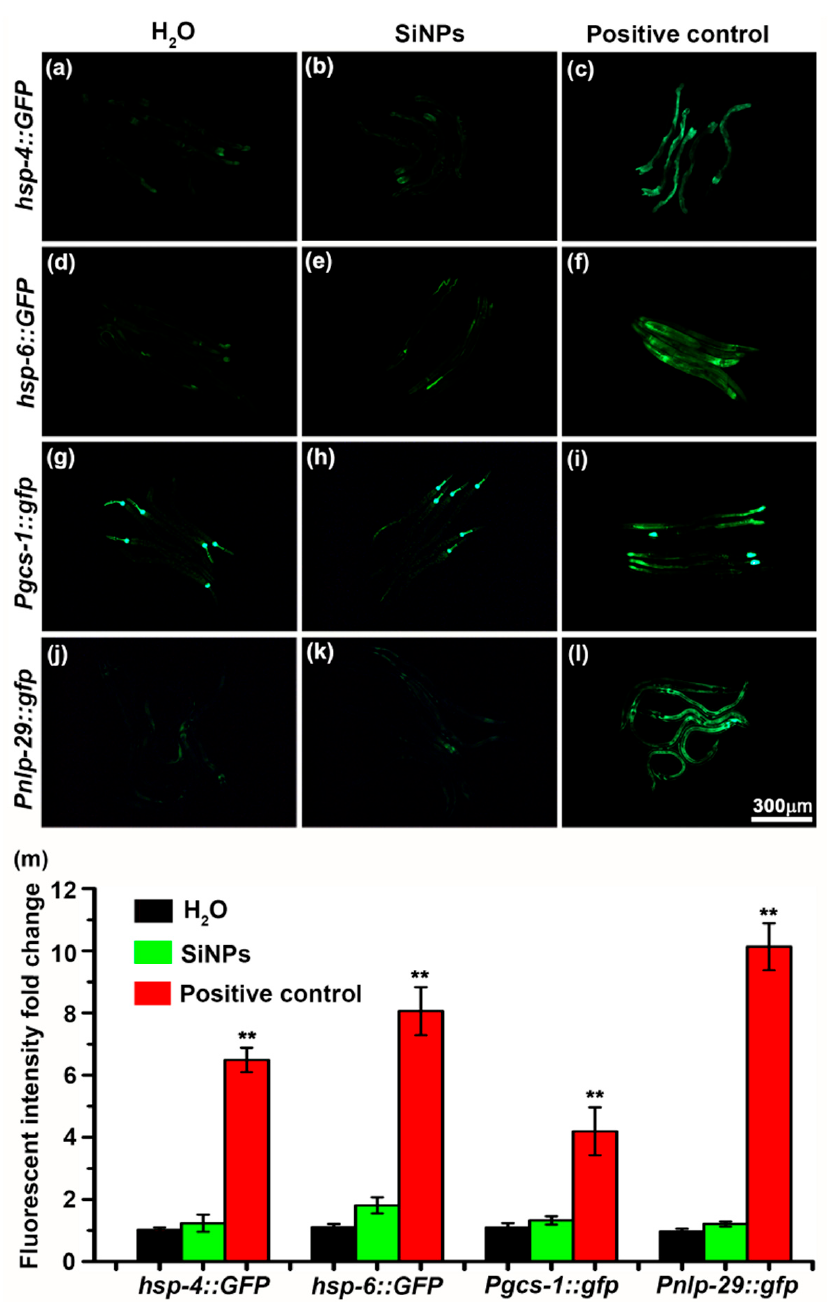
hsp-6::GFP (Figure 5e), and Pgcs-1::gfp (Figure 5h) fusion proteins were mostly unaltered compared with those of H 2 O-treated worms.